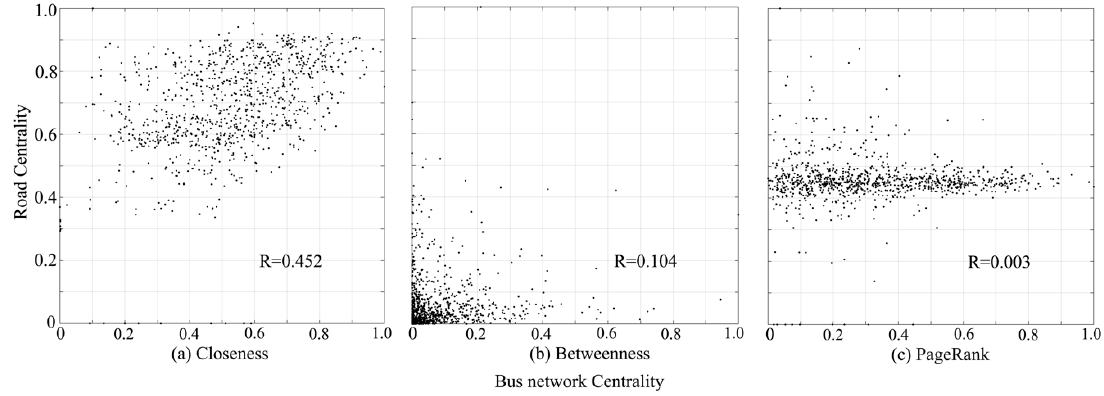
Figure 13. Correlation of centrality between the bus network and road network.